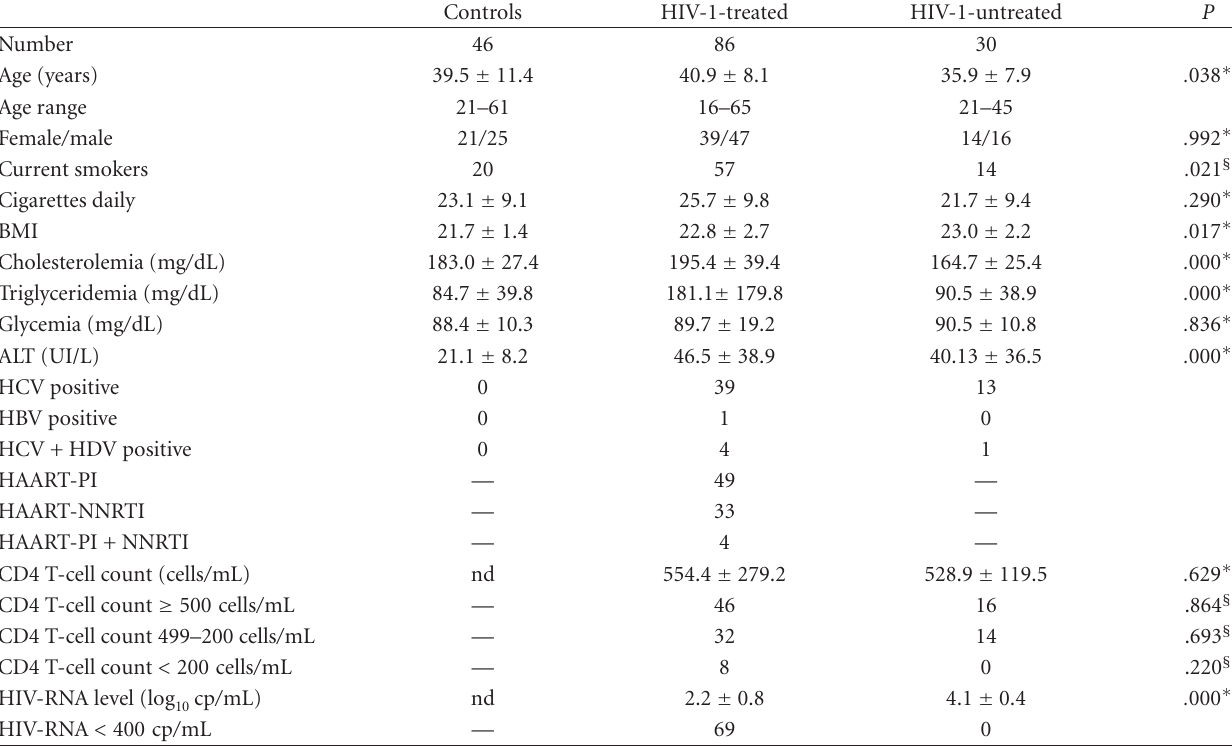
Table 1: Clinical data of HIV patients and controls.